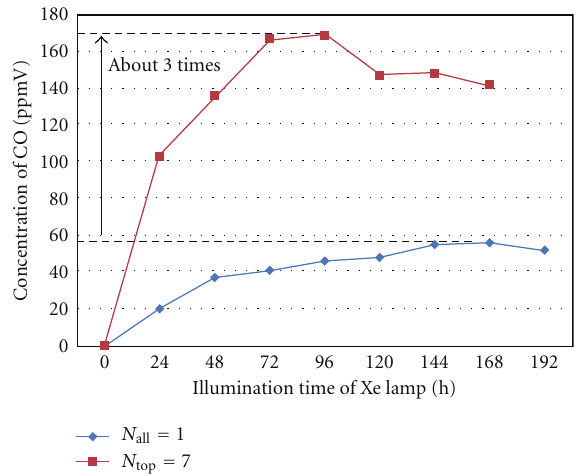
Figure 16: Comparison of concentration change of CO by CO 2 reforming with illumination time of Xe lamp without UV light for N = 7 and N = all top